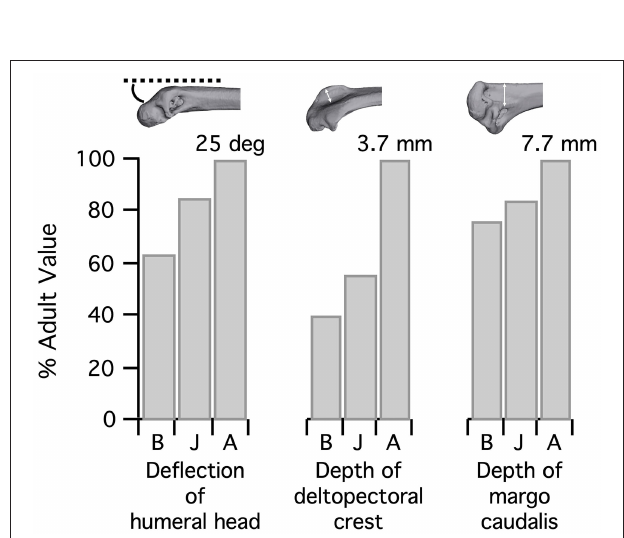
FIGURE 5 | Complexity of the humerus. The humerus grows more complex during ontogeny, as the humeral head is deflected away from the shaft and muscle attachment sites like the deltopectoral crest and bicipital crest (as measured by the margo caudalis, where several shoulder muscles attach) become exaggerated. Note that the depth of the deltopectoral crest is underestimated in baby and juvenile birds because cartilage was not measured here; however, muscles appear to attach to the ossified portion, so this measurement is the most functionally relevant. B, Baby chukar; J, Juvenile chukar; A, Adult